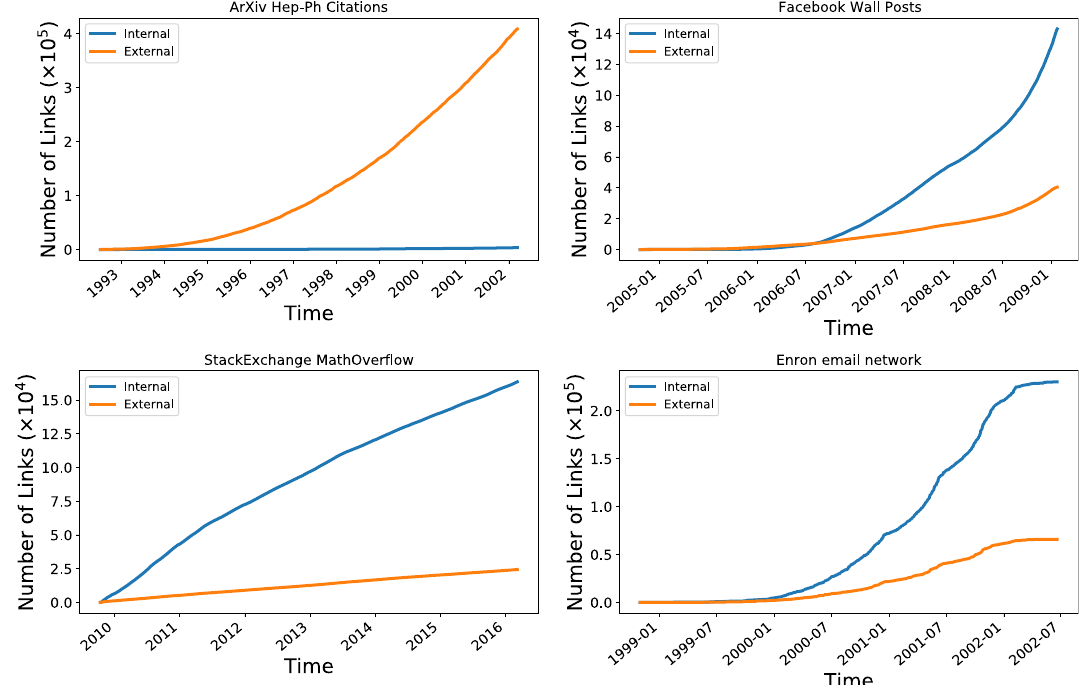
Figure 2. Number of edges in the network, split into those which join pairs of existing nodes (Internal) and those which join a new node to other new or existing nodes